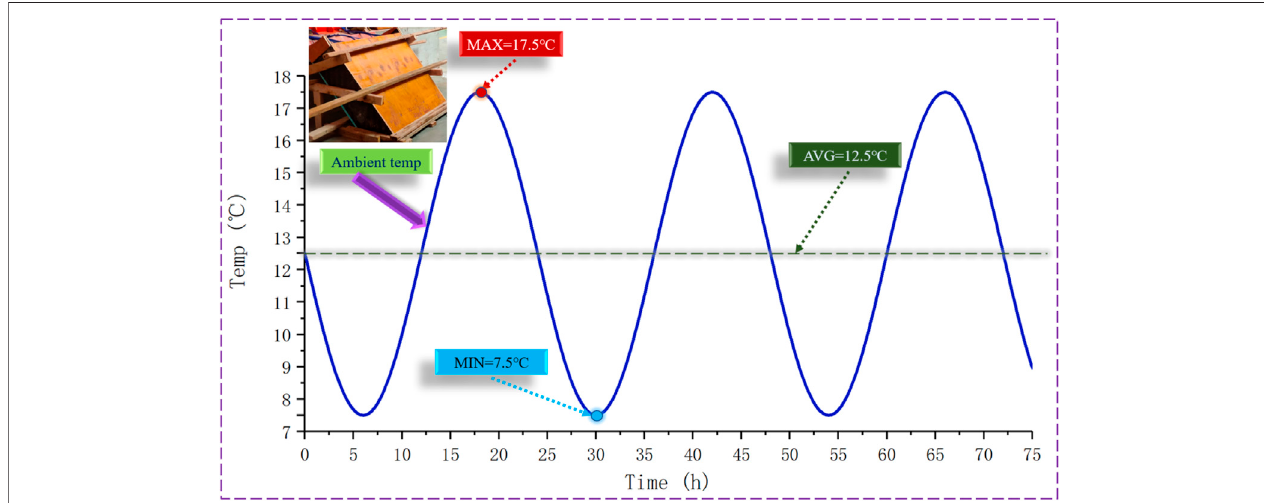
FIGURE 2 | Ambient temperature history curve after completion of pouring.